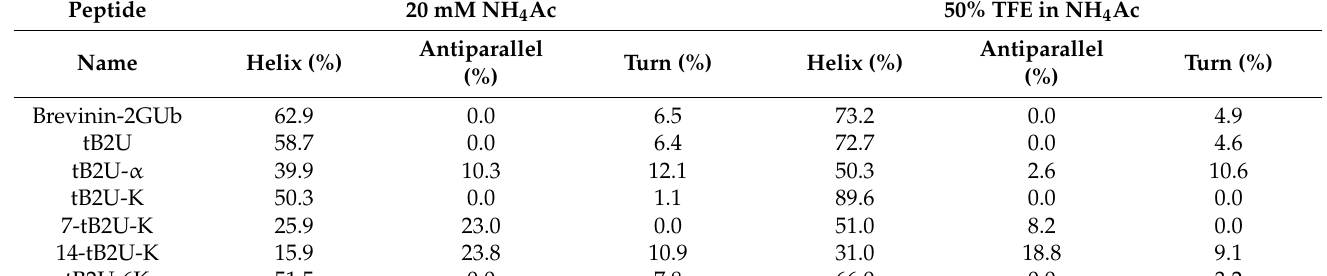
Table 2. Secondary structure analysis of Brevinin-2GUb and its analogues.